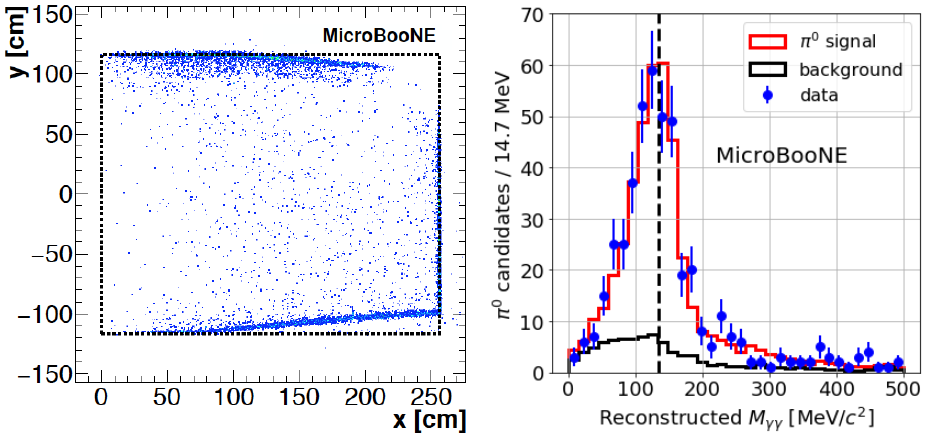
Figure 2. Calibrations of MicroBooNE with: ( left ) Cosmic ray muons: Entry/exit points of recon- structed muon tracks, showing a clear non-alignment with the TPC boundaries. Reproduced with permission from [14]. ( right ) Neutrino beam data: reconstructed invariant mass M γγ from candidate ν µ CC π 0 events after applying photon-shower energy corrections. Reproduced with permission from